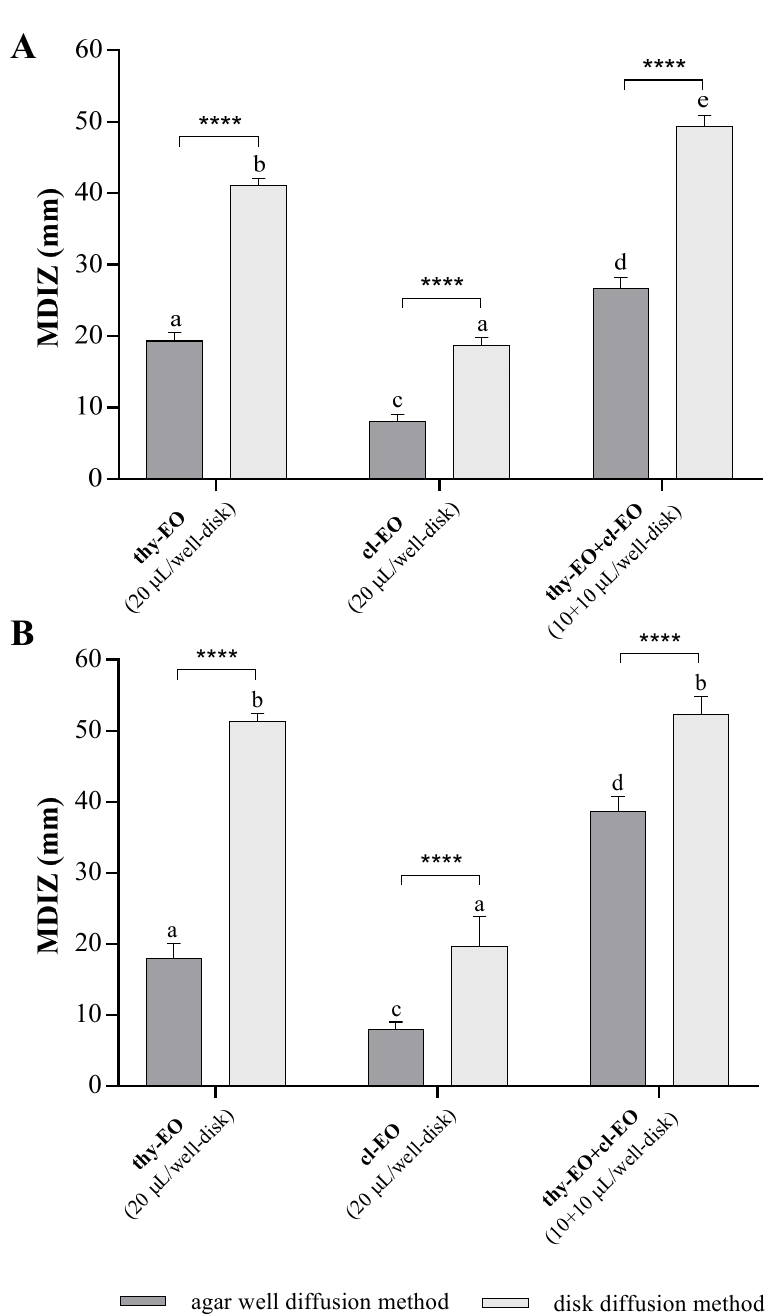
Figure 3. Comparative analysis of in vitro antimicrobial effects of thyme and cloves essential oils, individually used and in binary combination (1:1 ratio), evaluated with agar well diffusion method and with disk volatilization method against Escherichia coli ( A ) and Staphylococcus aureus ( B ) food isolates. The inhibition zone (in mm) is reported as mean value from triplicate assays ± standard deviation, performed using the same volume (20 µ L) of each tested antibacterial agent. Statistical significance was examined by two-way ANOVA test, with Tukey’s correction ( p < 0.05). Asterisks indicate the statistical significance between selected groups (**** p < 0.0001). Letters (a, b, c, d, e) are used for multiple comparisons between bars. Different letters indicate significant differences; bars with no significant differences receive the same letter. MDIZ, mean diameter of the inhibition zone. MDIZ, mean diameter of the inhibition zone; thy-EO, thyme essential oil; cl-EO, cloves essential